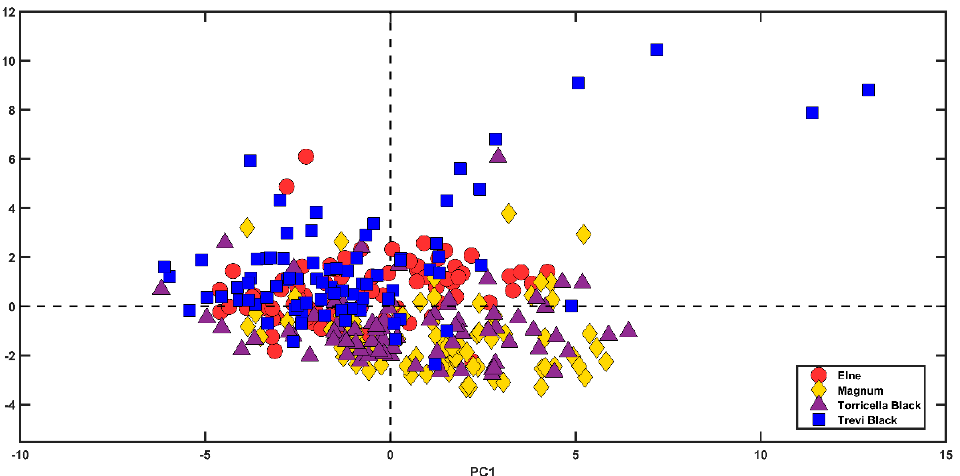
Figure A1. PCA. Samples projected onto the space spanned by the first two PCs. Legend: class Elne—red dots; class Magnum—blue squares; class Torricella Black—yellow diamonds; class Trevi Black—purple triangles.